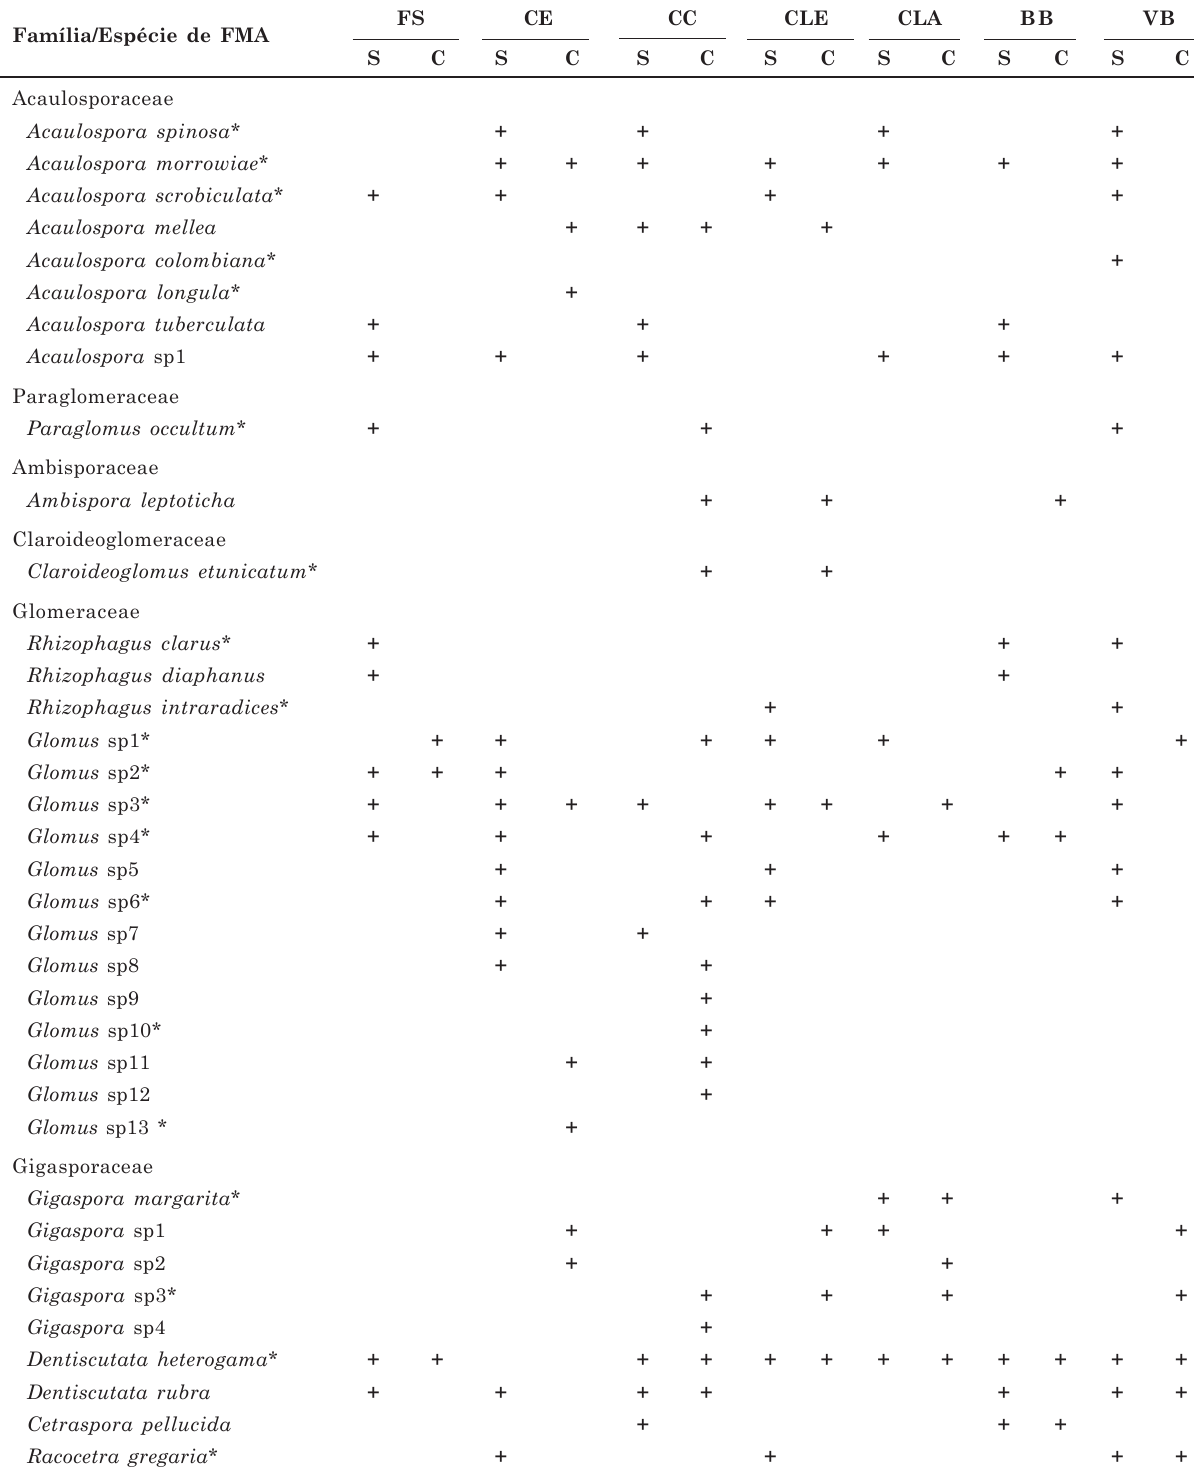
FS: floresta semidecídua; CE: cerradão; CC: campo cerrado; CLE: campo limpo com Elyonorus muticus ; CLA: campo limpo com Axonopus purpusii ; BB: borda de baía; e VB: vazantes e baixadas. *Espécies de FMA detectadas também em culturas armadi-